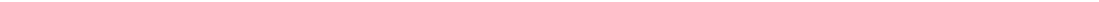
(See figure on next page.) Fig. 6 Selected approximately E–W direction velocity profiles transversing the Longitudinal Valley. All the E–W profiles are shown in the supplementary. The #1 denotes the “western‑group clusters” between 25 and 15 km deep. The #2 denotes the “eastern‑group clusters”. The #3 denotes the clusters likely produced by the seismic activity of the deeper part of the LVF, whereas the #4 denotes the clusters likely associated with the rupture of the shallow part of the LVF. See maintext for detailed discussion. The gray circles and gray beachballs are the relocated hypocenter of background seismicity and focal mechanisms from AutoBATS (Jian et al. 2018). The black circles and purple beachballs are the relocated hypocenter and redetermined first‑motion focal mechanism of the 28 earthquake clusters. Structural interpretation is delineated by translucent lines and arrows in the upper panels. LVF Longitudinal Valley Fault, MLF Milun Fault. The profile location is shown in Fig.